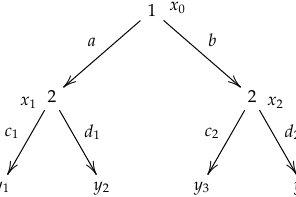
Figure 4. Extensive form game tree. The nodes are labeled with turns of players (Players 1 and 2) and the edges with the actions. The syntactic representation of this tree can be given by: z “ pp 1, x 0 q , a , t 1 q ` pp 1, x 0 q , b , t 2 q , where t 1 “ pp 2, x 1 q , c 1 , p 2, y 1 qq ` pp 2, x 1 q , d 1 , p 2, y 2 qq